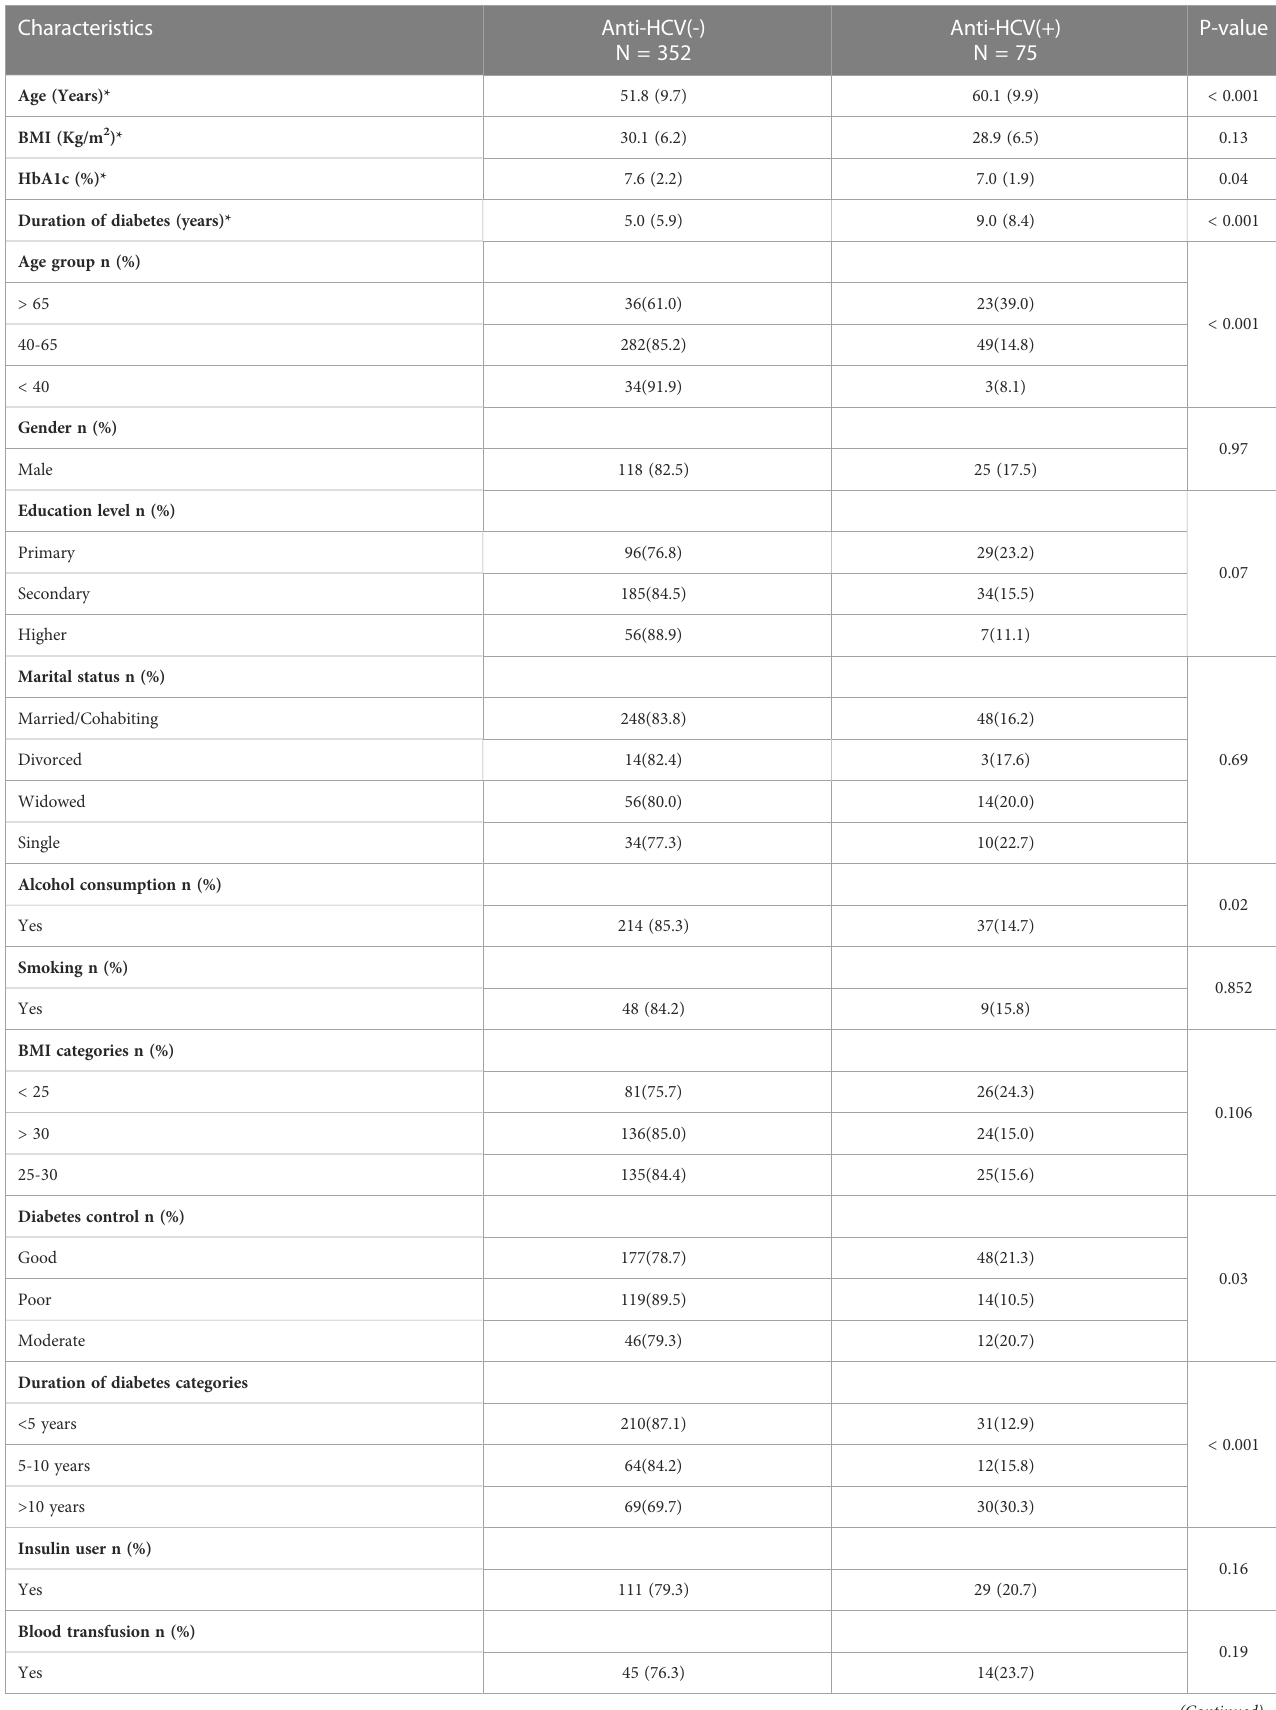
TABLE 3 Seroprevalence of HCV infection in type 2 diabetic patients according to clinical characteristics and history of exposure to HCV infection.